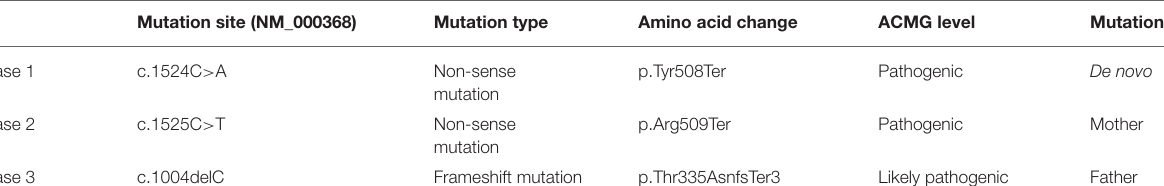
TABLE 2 | Mutations in the TSC1 gene.